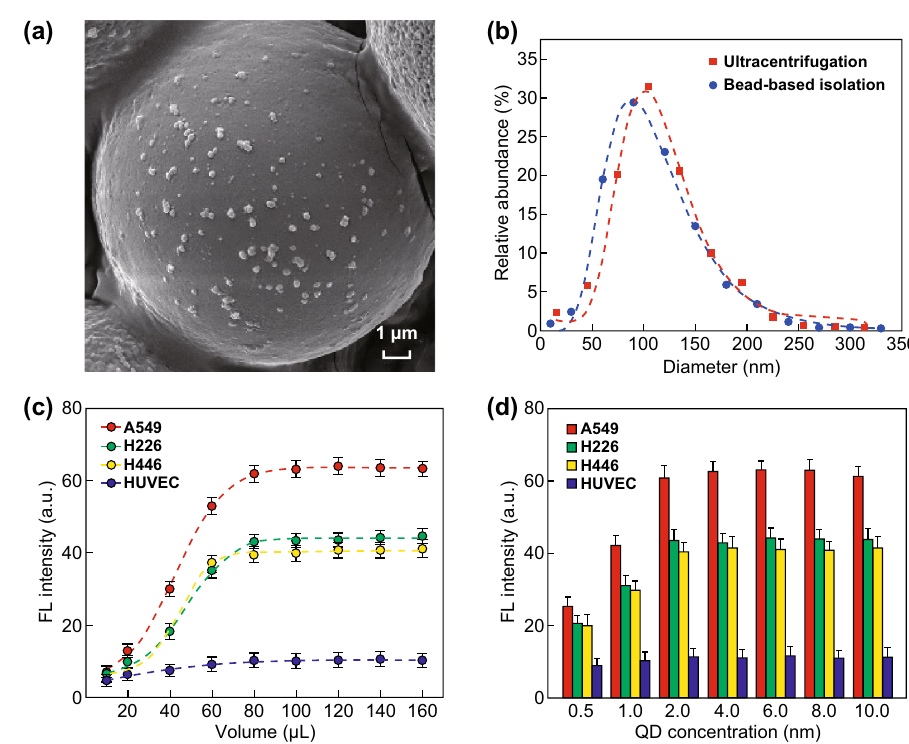
Fig. 3 Morphological characterization of exosomes and optimization of the immunoassay system. a SEM image of exosomes bound to the bead surface. b Diameter distribution of bead-based isolated exosomes using particle analysis of SEM images ( R 2 = 0.996) compared with NTA of ultracentrifugation-isolated exosomes ( R 2 = 0.982). Dashed lines represent log-normal fitting. c , d Variation in the fluorescence intensities of different cell lines according to increasing volumes of cell culture supernatant ( c ) and QD concentrations ( d ). Dashed lines represent sigmoidal dose–response fitting ( R 2 >